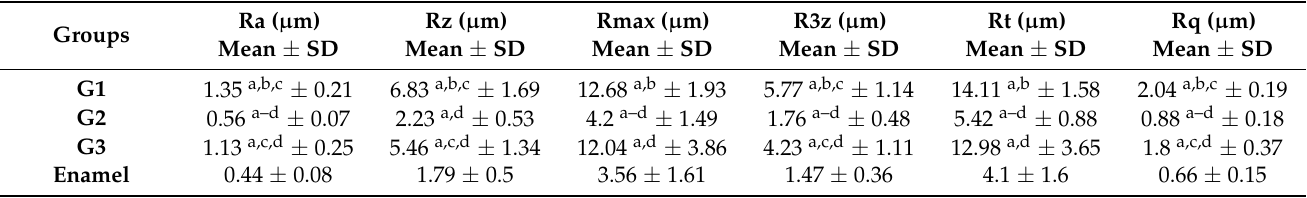
Table 2. Comparison of mean values of enamel roughness parameters, obtained for G1–G3 samples and enamel that were not treated with